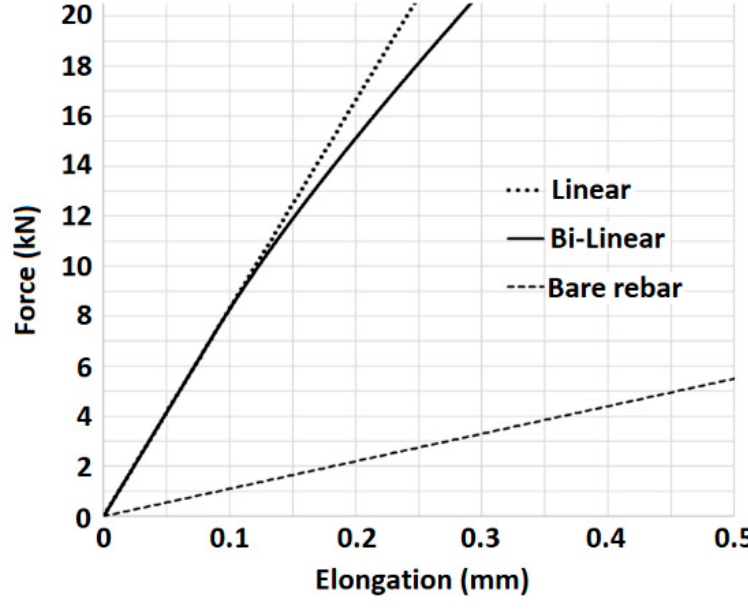
Figure 5. Bar elongations.